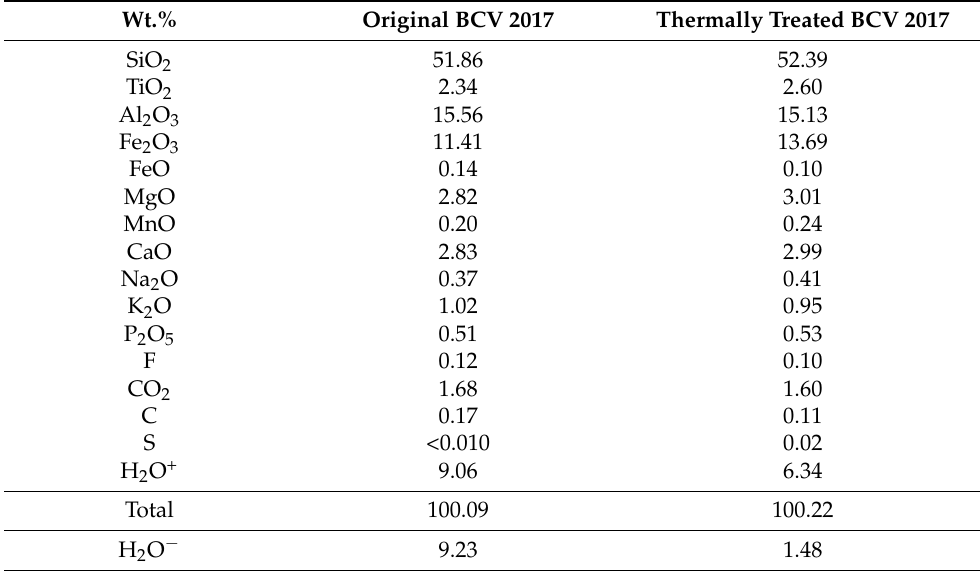
Table 1. Chemical composition of the original and the thermally treated bentonite BCV 2017.